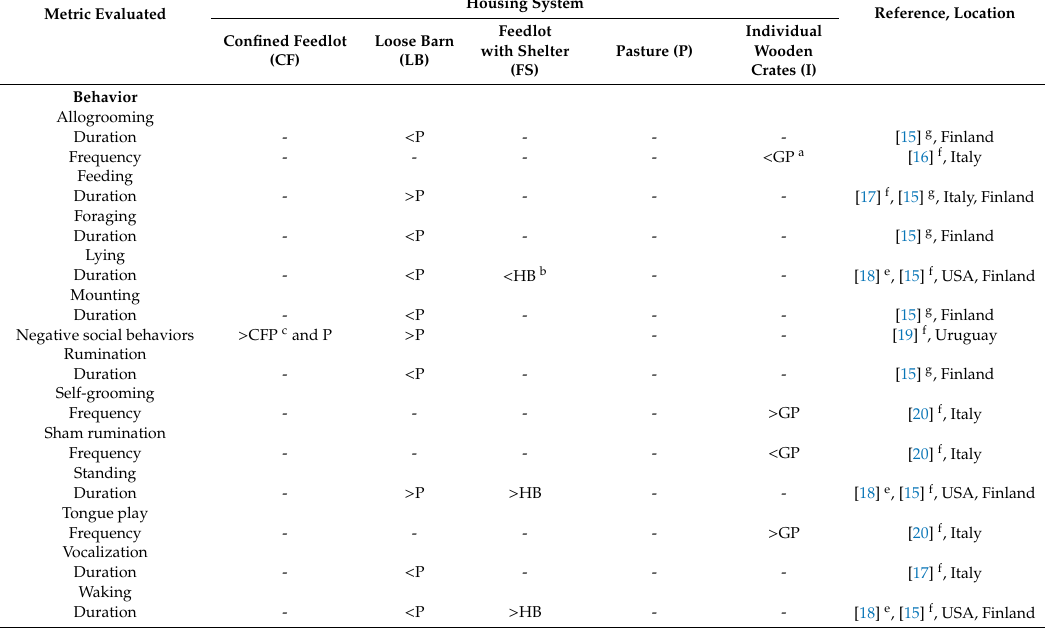
Table 4. Overview of the e ff ect of di ff erent housing system types on beef cattle behavior, productivity, product quality and physiology. Housing systems are reported in the same language as they were presented by original study authors. Inclusion of significant results was determined at p <